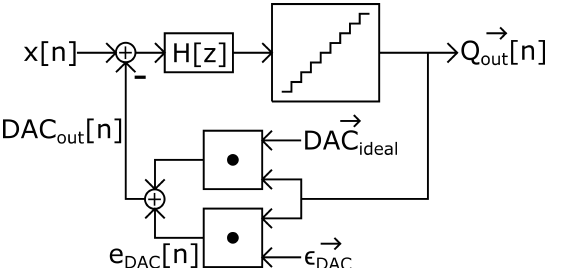
Figure 7. System-level model of a DT- Σ∆ M showing how the DAC mismatch introduces an addi- tional error.